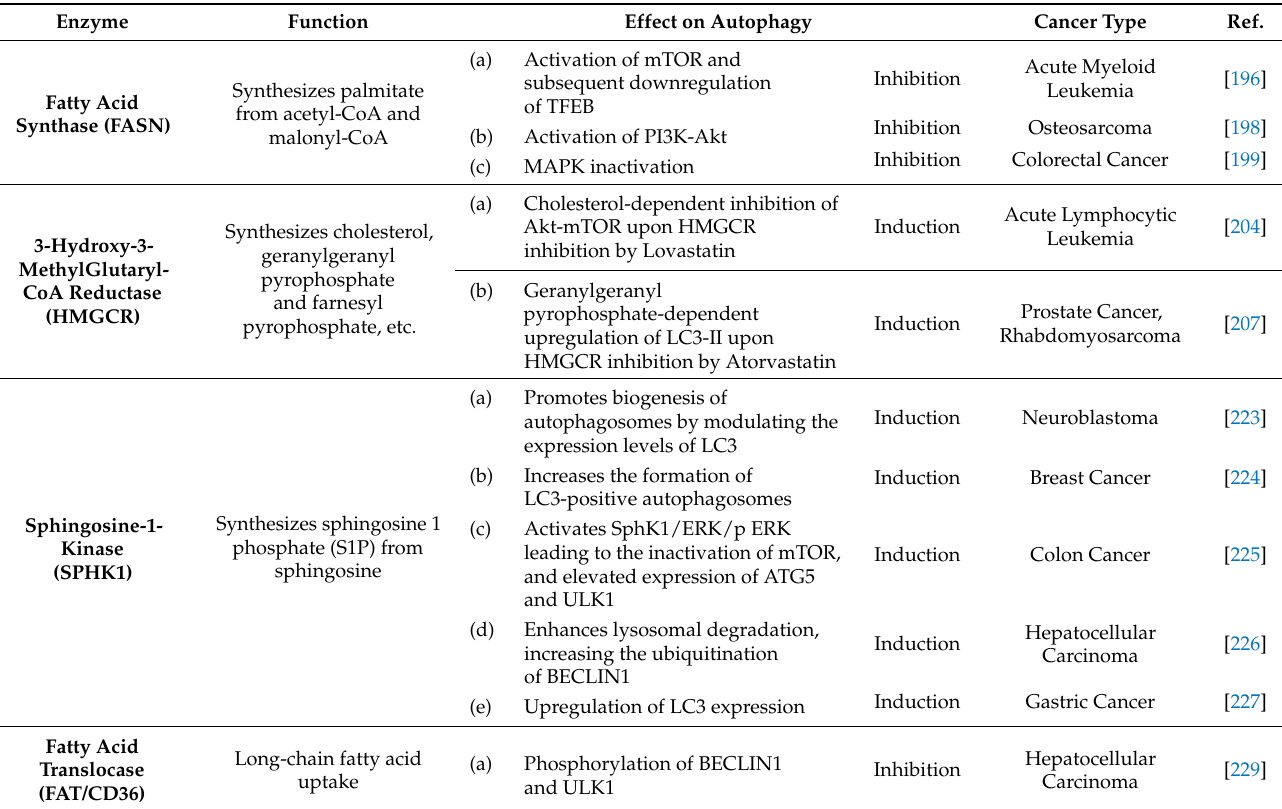
Table 2. The effect of enzymes involved in lipid metabolism on different steps of autophagy. Effect on Autophagy Cancer Type